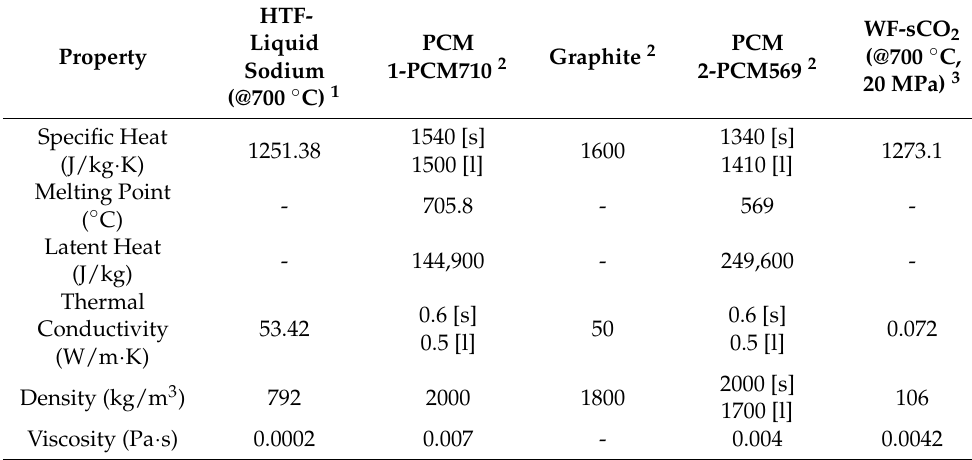
Table 1. Thermophysical Properties of Studied Materials.